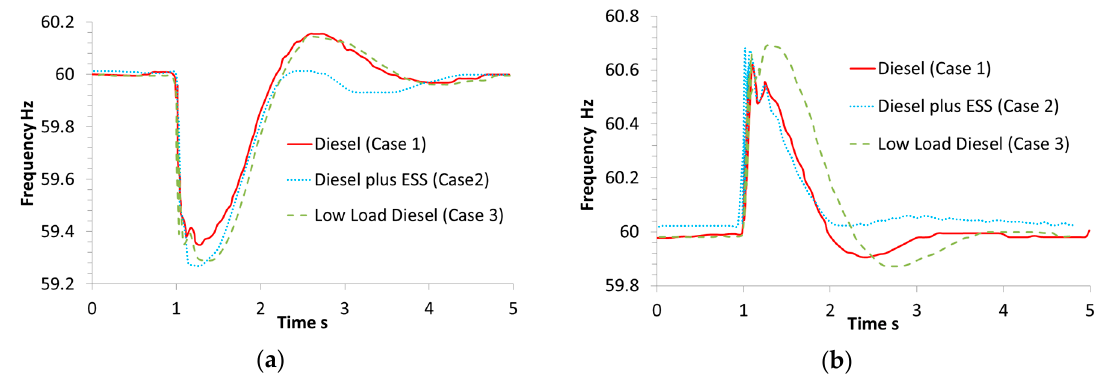
Figure 6. ( a ) System frequency response to 60% rated capacity step load increase; ( b ) system frequency response to 60% load decrease for diesel, diesel plus ESS and LLD case studies.